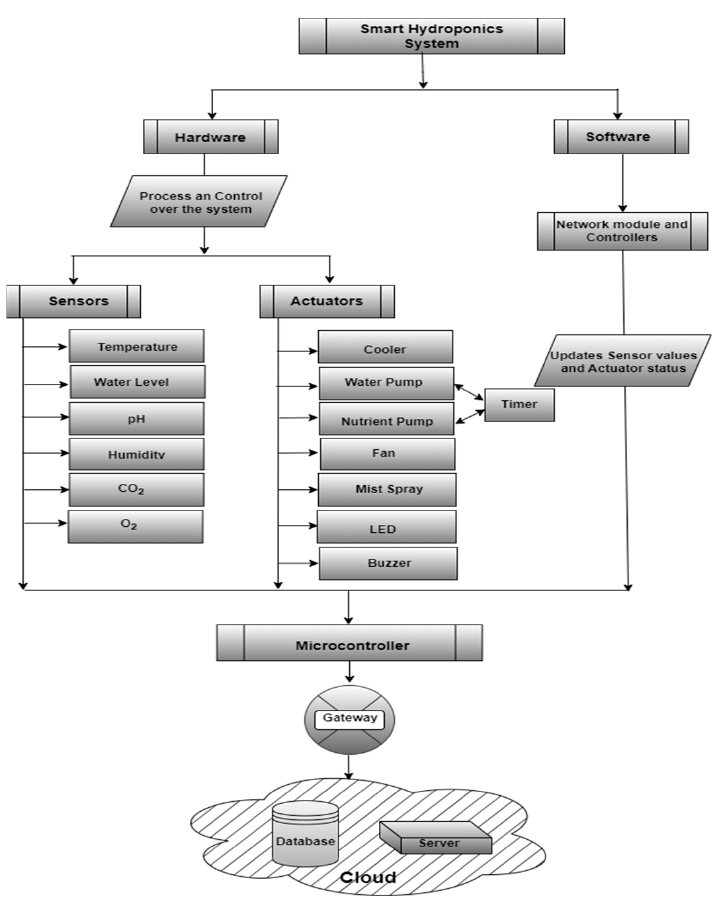
Figure 9. Components of the proposed smart hydroponic system.